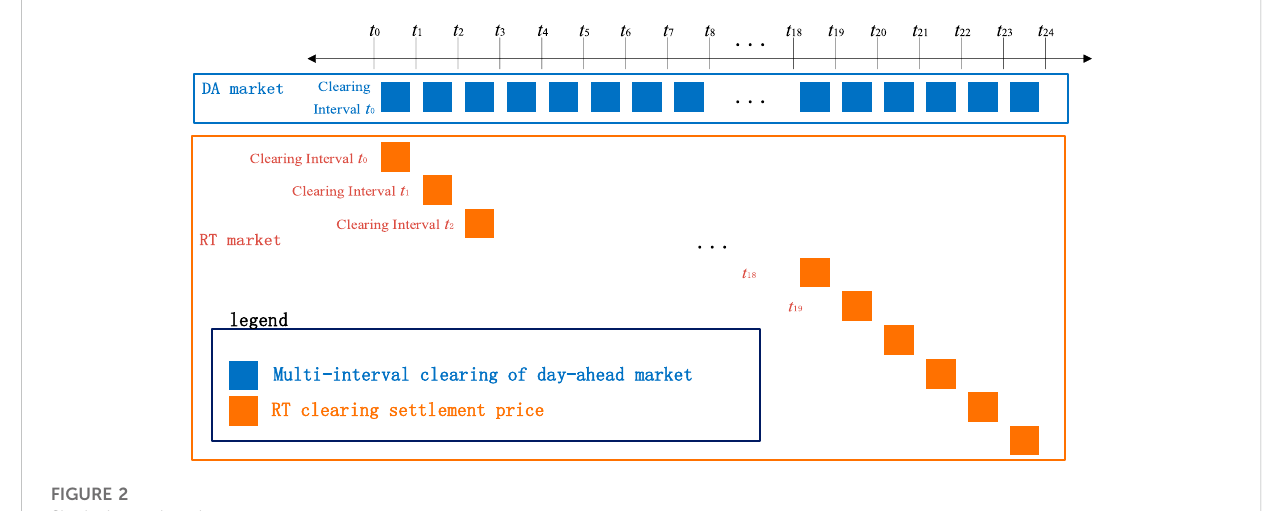
FIGURE 2 Single-interval